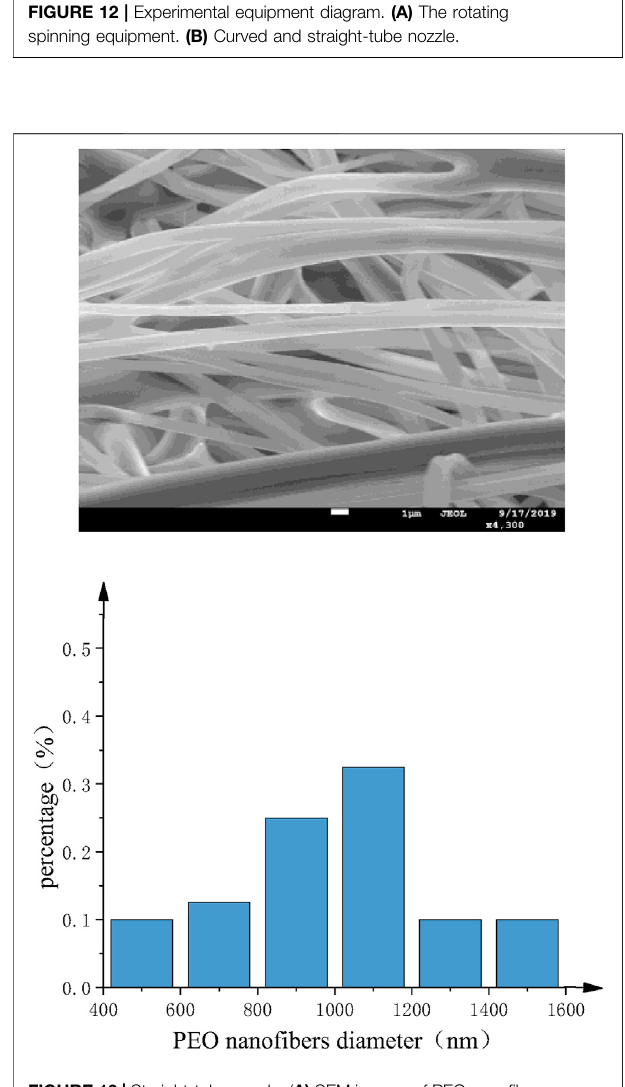
FIGURE 13 | Straight-tube nozzle. ( A) SEM images of PEO nano fi bers. (B) Histogram of fi ber diameter